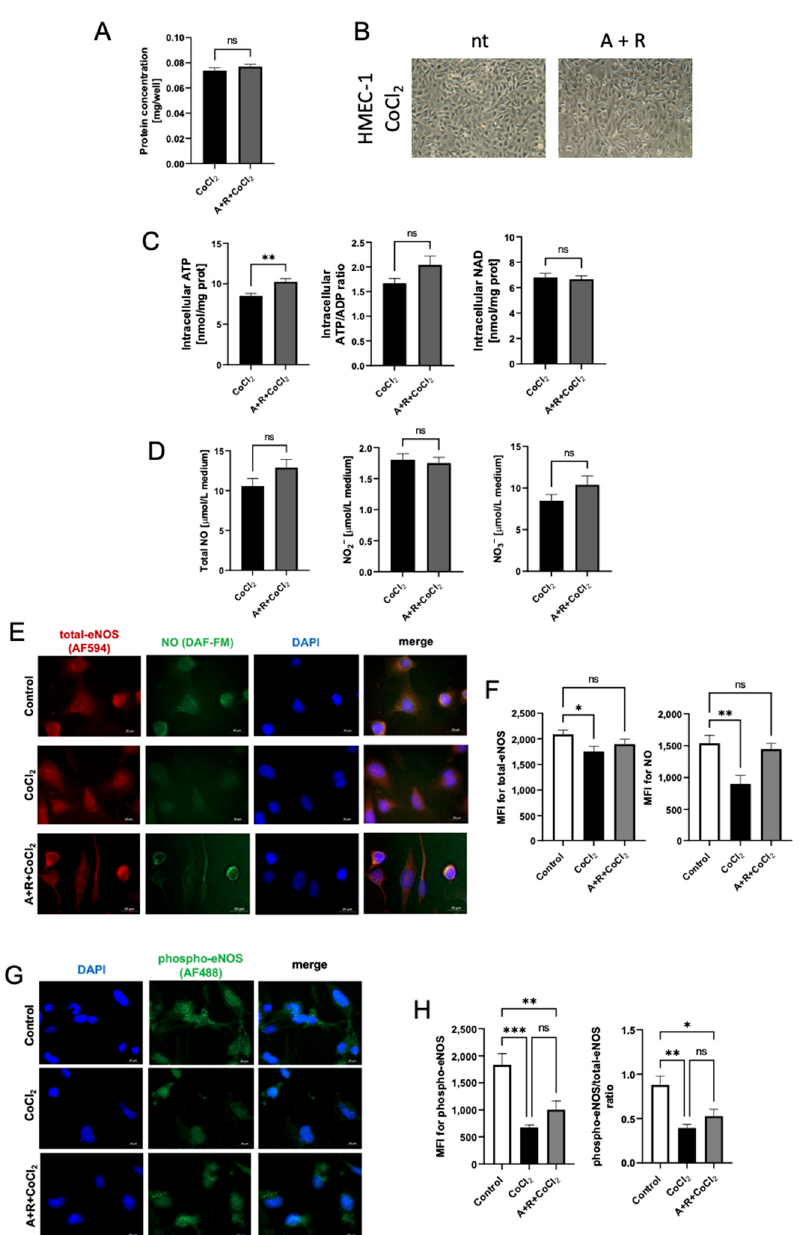
Figure 6. Adenine and ribose supplementation improved intracellular nucleotide status and function of HMEC-1 cells under hypoxia-mimic conditions. ( A ). Total cell protein, ( B ). Representative HMEC-1 cell images after CoCl 2 stimulation in the presence (A + R) and absence (nt) of 100 μ M adenine and 2.5 μ M ribose; ( C ). Intracellular nucleotide concentration after A + R treatment during hypoxia-mimic conditions. ( D ) The concentration of total NO, NO 2– and NO 3– in the cell culture media after adenine and ribose treatment (A + R) after 24 h of CoCl 2 treatment. ( E ). Representative images presenting fluorescence staining of total endothelial nitric oxide synthase (total-eNOS, red), nitric oxide (NO, green), and nuclei (blue). ( F ). Quantitative analysis of mean fluorescence intensity (MFI) for total eNOS and NO staining in control cells and after CoCl 2 treatment in the presence and absence of A + R supplementation. ( G ). Representative images presenting fluorescence staining of phosphorylated endothelial nitric oxide synthase at Ser 1177 (phospho-eNOS, green), and nuclei (blue). ( H ). Quantitative analysis of MFI for phospho-eNOS and phospho-eNOS/total-eNOS ratio in control cells and after CoCl2 treatment in the presence and absence of A + R supplementation. Results are shown as mean ± SEM; n = 6; * p < 0.05, ** p < 0.01, *** p < 0.001; ns = not significant.